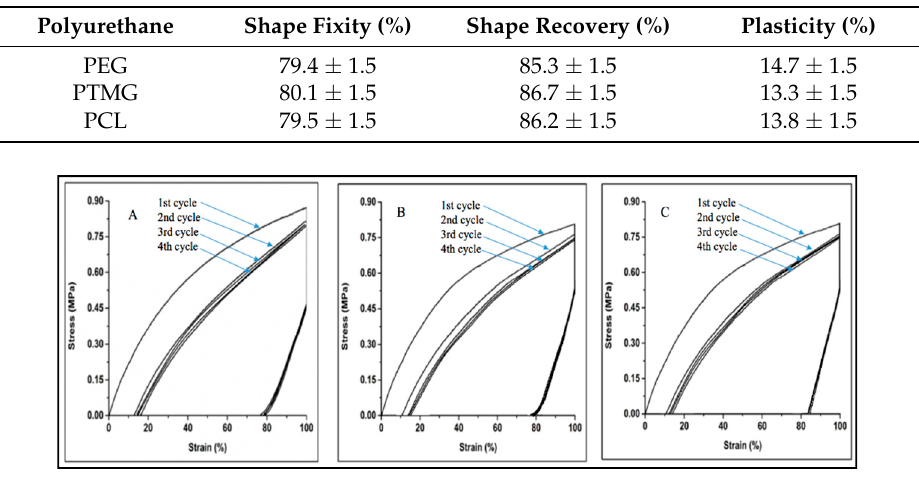
Figure 11. Thermo-mechanical cyclic curves of ( A ) Polyethylene Glycol (PEG); ( B ) Polycaprolactone (PCL); ( C ) Polytetramethylene Glycol (PTMG). Table 3. The shape memory properties of the different polyurethanes.